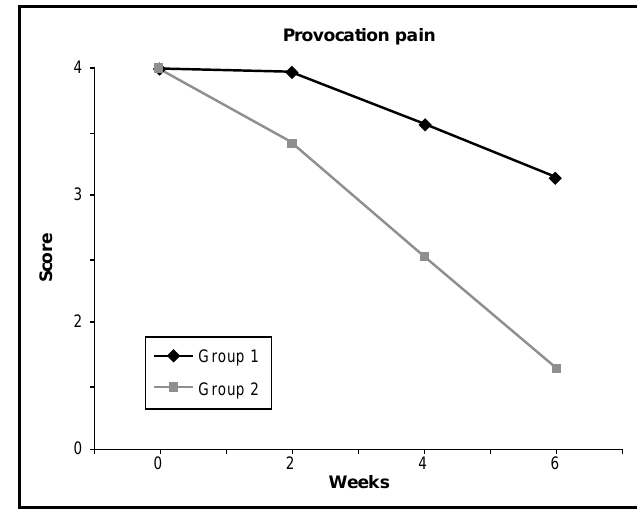
Figure 8: Development of provocation pain for the six week-course of treatment in the therapy groups.